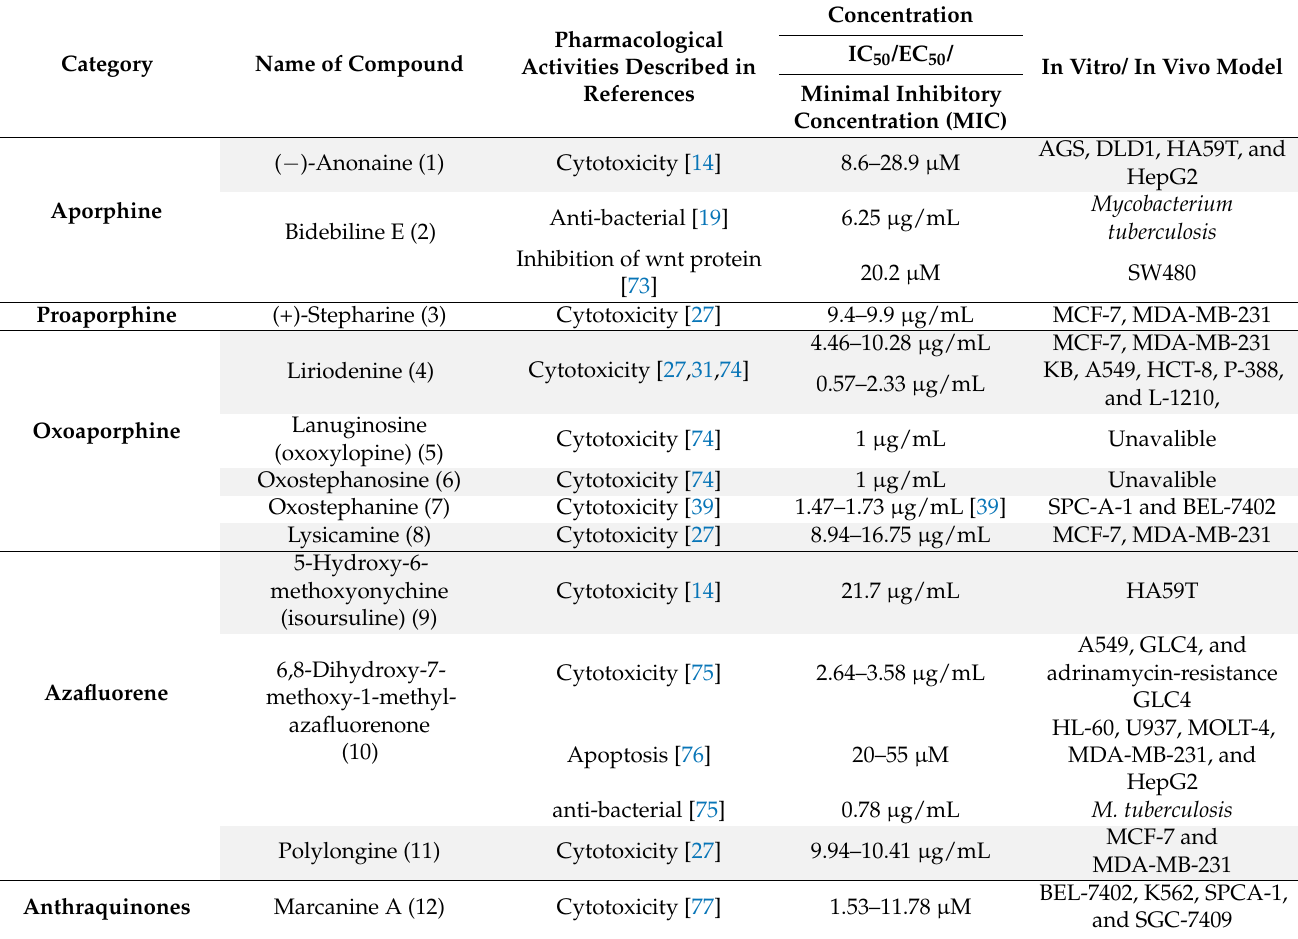
Table 1. Bioactive compounds isolated from Polyalthia